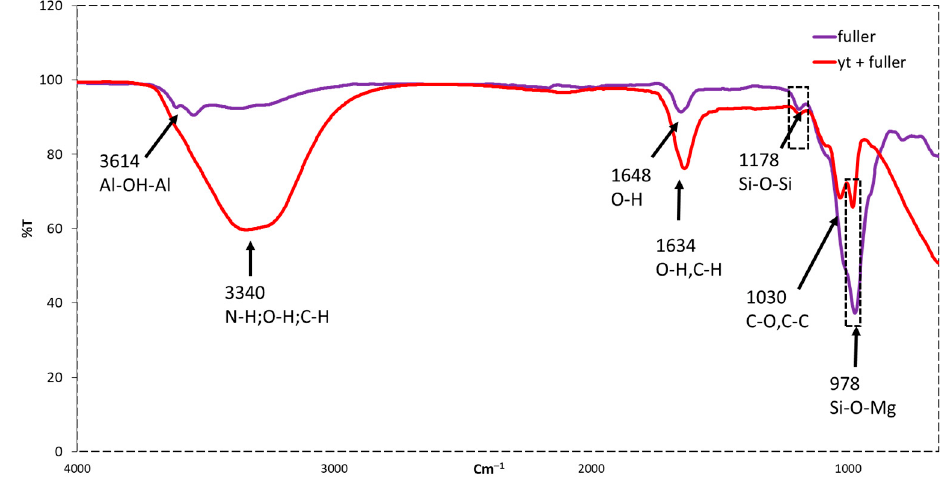
Figure 13. FTIR spectra of Fuller earth and immobilized YT PTE. Red line: Immobilized YT PTE; Purple line: Fuller’s earth. The black arrow indicates each peak, and the dotted box indicates similar peaks for both lines.